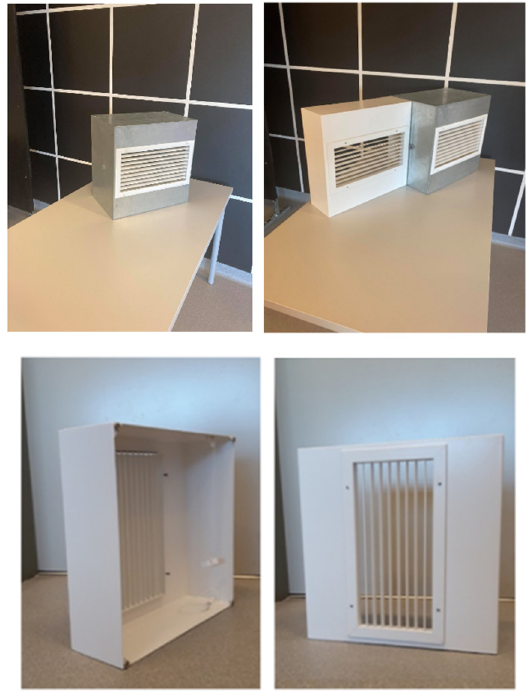
Figure 14. Upgraded air jet control box.